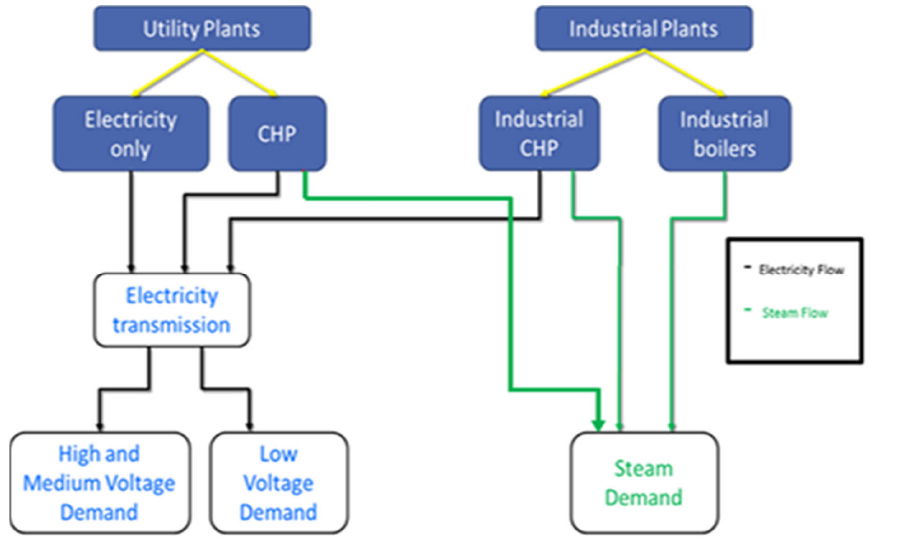
Figure 3. Representation of Energy Supply system [22] . Table 4. Available plant technologies